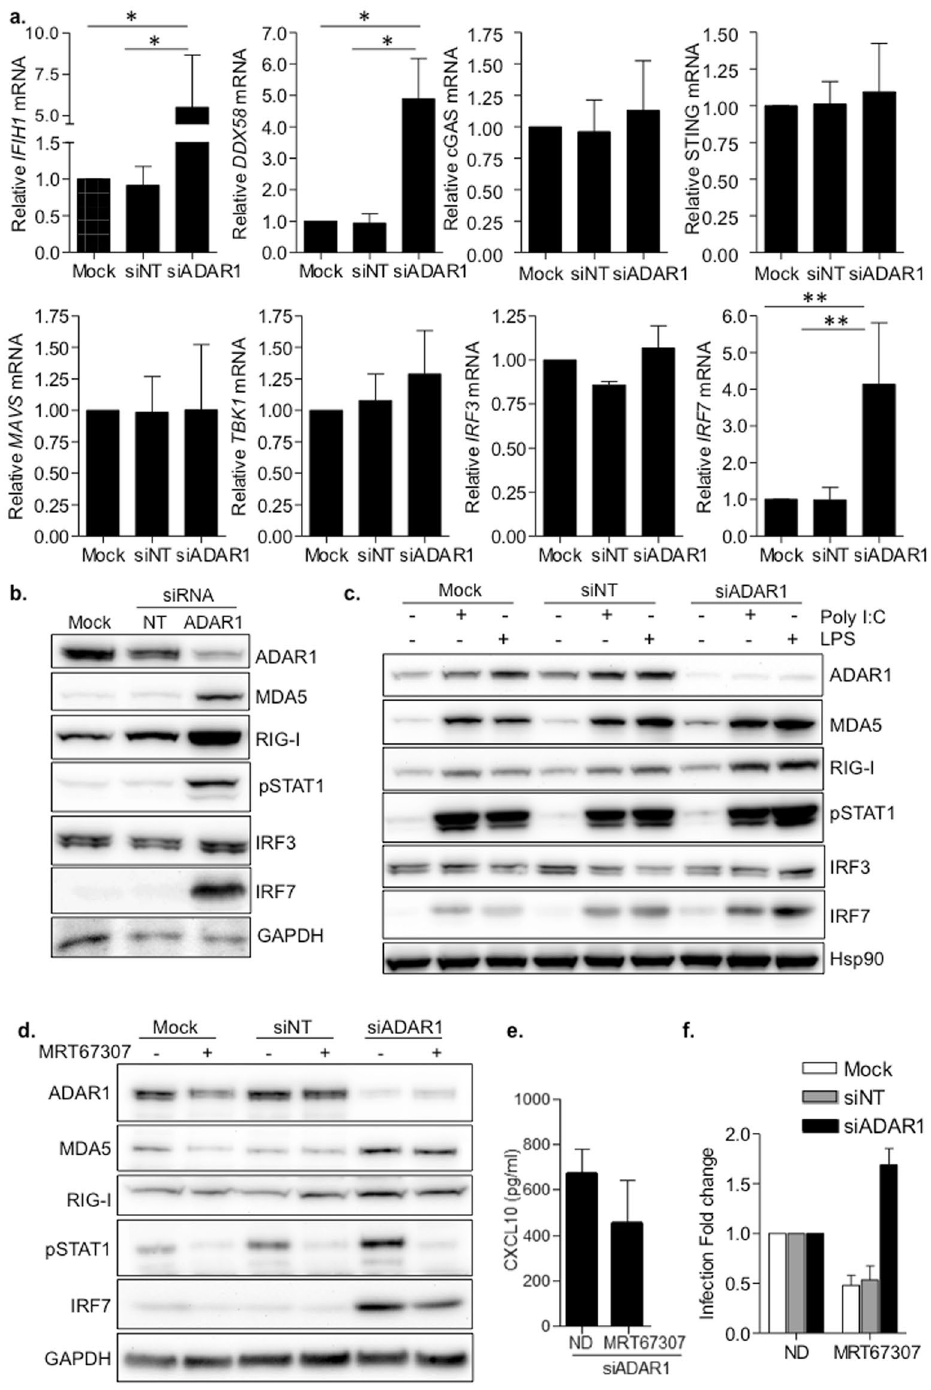
Figure 4. ADAR1 specifically regulates the RLRs-MAVS signaling pathway. ( a ) Relative mRNA expression of RLRs ( IFIH1 and DDX58 ), DNA sensors (cGAS and STING), downstream signaling proteins ( MAVS , TBK1 ) and transcription factors ( IRF3 and IRF7 ) in ADAR1 knockdown macrophages. Data represents mean ± SD of at least 4 different donors and is normalized to Mock-transfected macrophages. * p < 0.05; ** p < 0.005. (b) Protein expression of RLRs and related proteins in macrophages, showing overexpression of MDA5, RIG- I, pSTAT1 and IRF7 consequence of ADAR1 inhibition. A representative donor is shown. (c) Western blot showing protein expression pattern in transfected macrophages, stimulated or not with LPS (100 ng/ml) or Poly I:C (10 µ g/ml) to resemble canonical TLR-mediated activation of type I IFN response. A representative donor is shown. (d) Protein expression in ADAR knockdown macrophages treated with the TBK1 inhibitor MRT67307 (5 µ M). Blocking TBK1 function partially restores protein expression phenotype observed in Mock- or siNT- transfected macrophages. A representative donor is shown. (e) CXCL10 protein expression in the supernatant in ADAR1 knockdown macrophages, treated or not with MRT67307 (5 µ M). CXCL10 protein in the